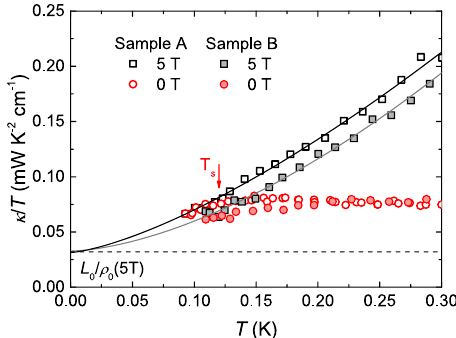
Fig. 3 Veri fi cation of Wiedemann – Franz Law in Pr 2 Ir 2 O 7 . The thermal conductivity of two Pr 2 Ir 2 O 7 single crystals at µ 0 H = 0 and 5T along the [111] direction, respectively. Solid lines are the fi ts of the thermal conductivity data to κ /T = a + bT α − 1 at 5T below 0.3K. The dashed line is the Wiedemann- Franz law expectation L 0 / ρ 0 (5T) = 0.032mWK − 2 cm − 1 for sample A at 5T, which meets the extrapolated κ /T ≡ a = 0.031mWK − 2 cm − 1 very well.